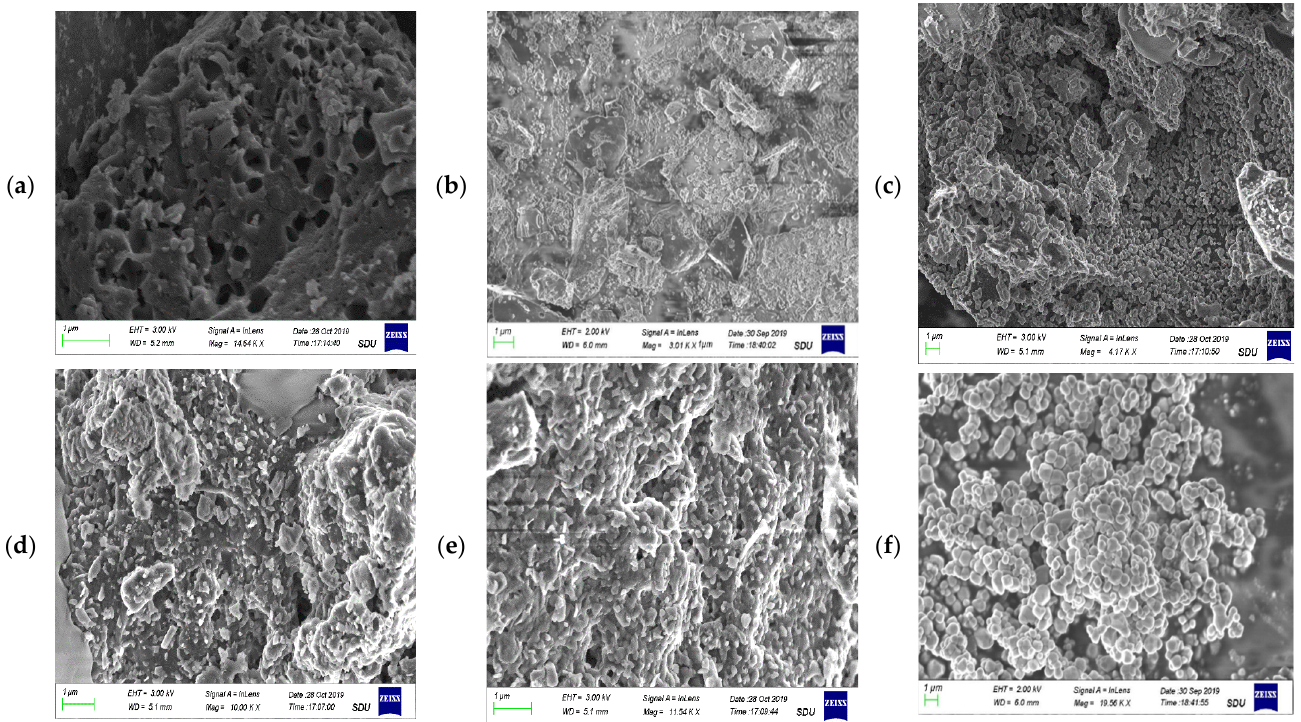
Figure 2. SEM micrograph of ( a ) biomass; ( b ) biochar; ( c ) TiO 2 NC; ( d ) lead-loaded biomass; ( e ) lead-loaded biochar; and ( f ) lead-loaded TiO 2 NC.